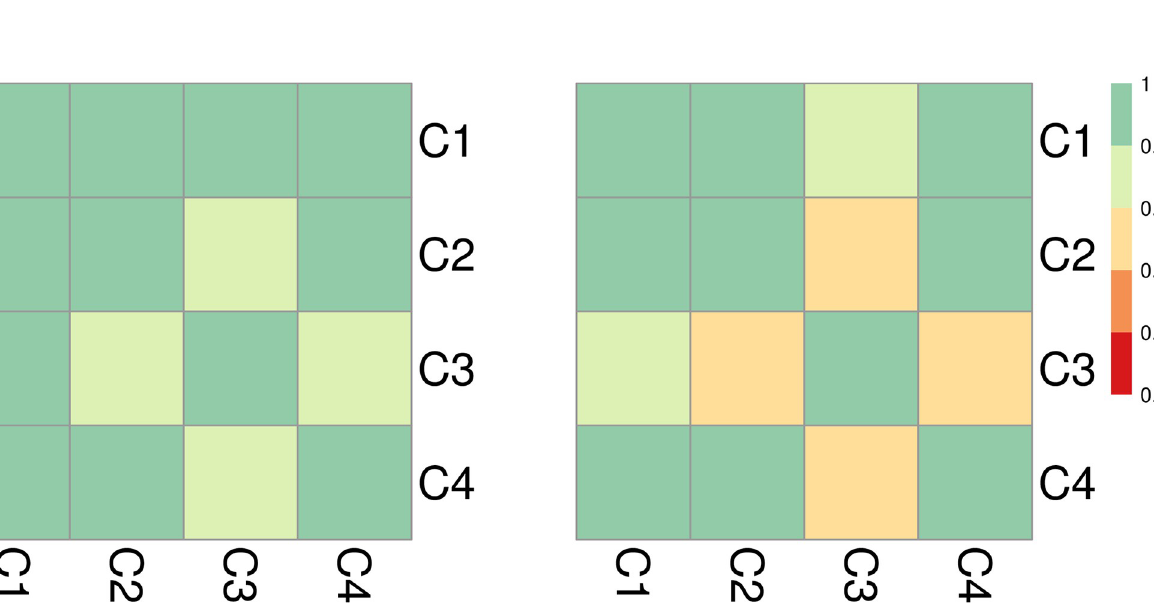
PLOS ONE | https://doi.org/10.1371/journal.pone.0250433 April 22,